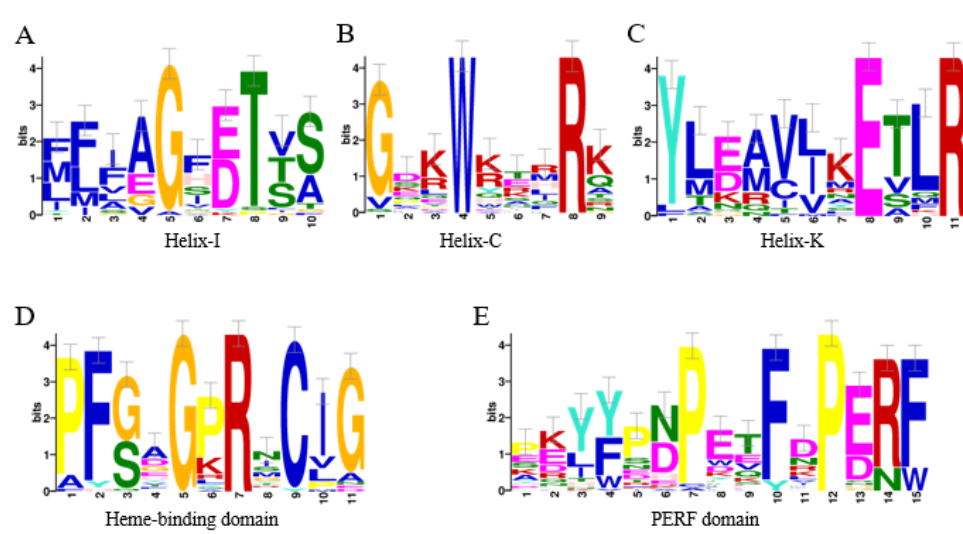
Figure 1. Motif and variation patterns among Pseudoregma bambucicola P450 genes. The height of a letter indicated its relative frequency at the given position for the amino acid. Small sample correction is shown above the amino acids. Five conserved regions are shown here: ( A ) helix-I (GxE/DTT/S); ( B ) helix-C (WxxxR); ( C ) helix-K (ExLR); ( D ) heme-binding domain (PFxxGxRxCxG/A); and ( E ) PERF domain (PxxFxPE/DR).